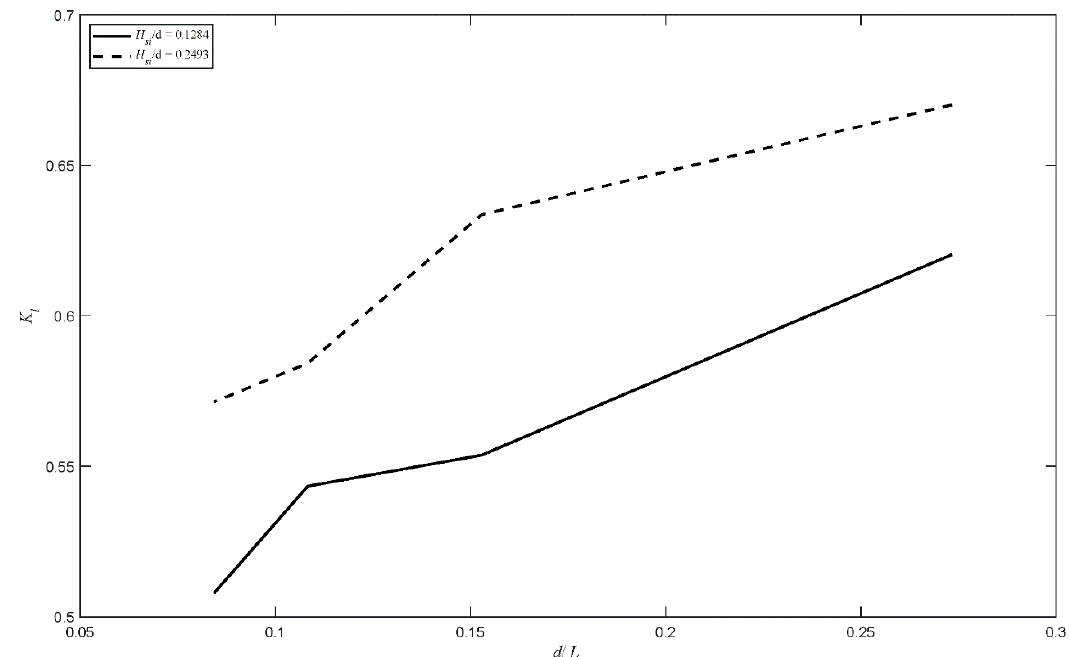
= 1, P = 20%, and θ = 90 ◦ . J. Mar. Sci. Eng. 2020 , 8 , x FOR PEER REVIEW